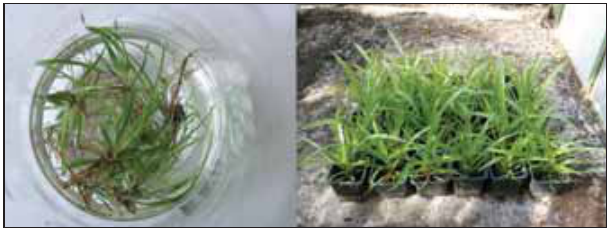
Figure 3. Collected in vitro Nidularium ’Kertész Jubileum’ plants before preparing tissue extract (left) and an acclimatized group after the trial (right)